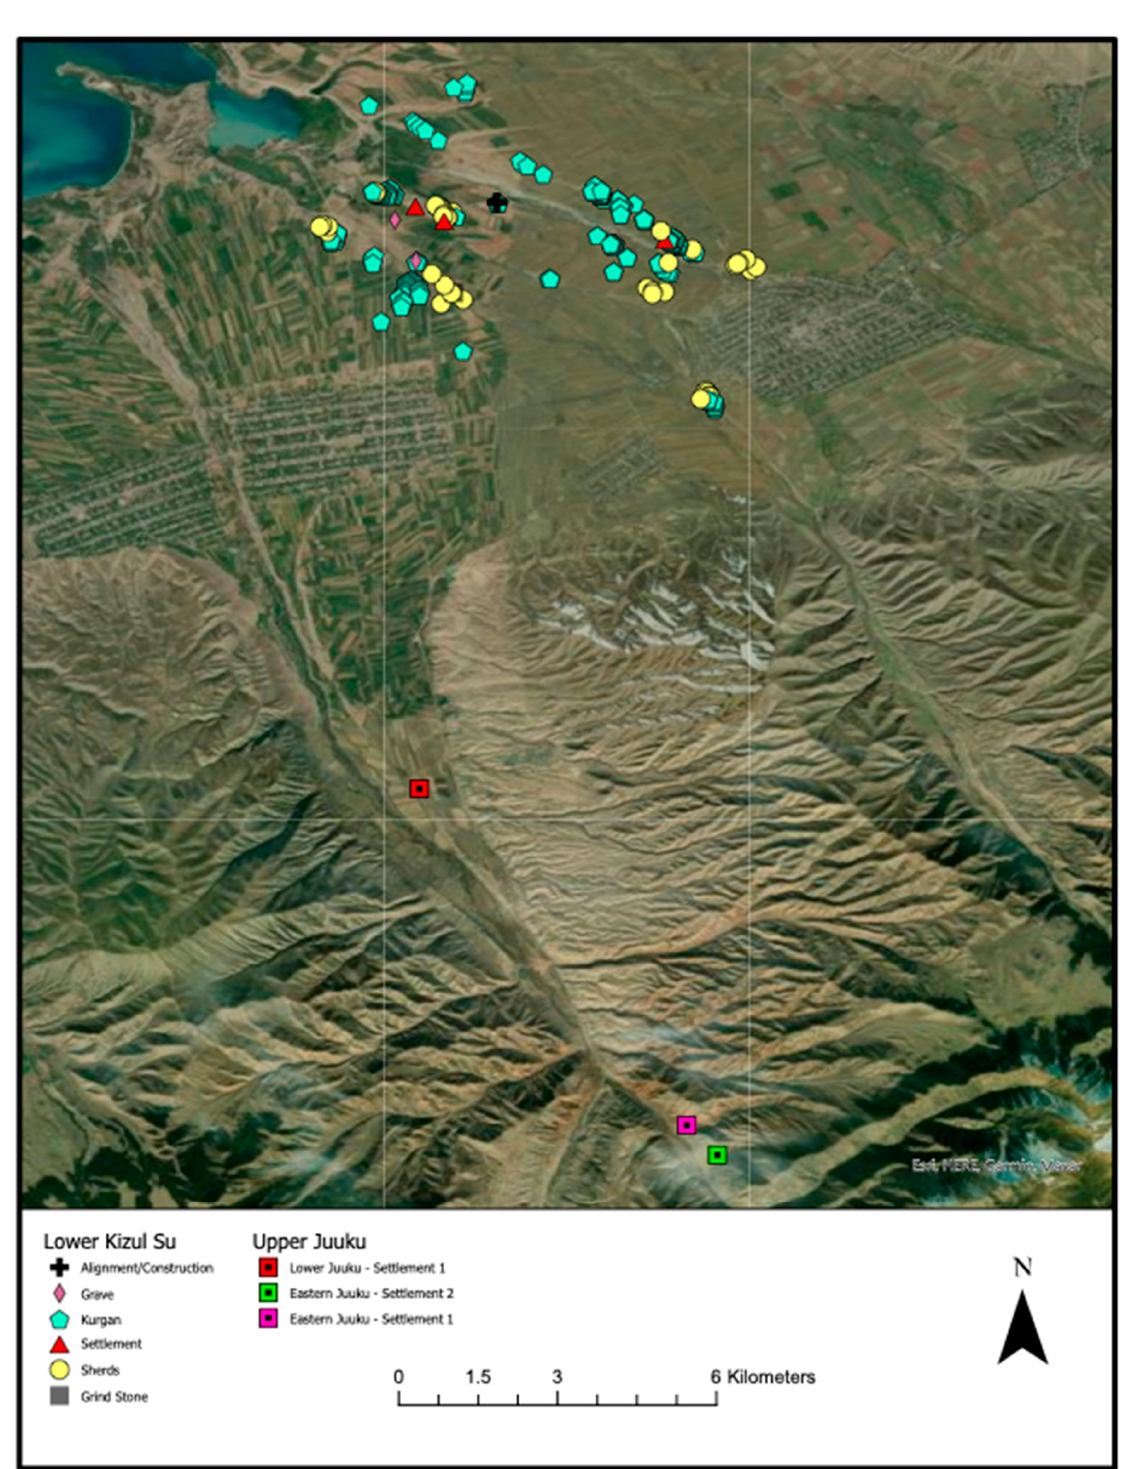
Figure 2. Map of Lower Kizil Suu Survey also shows the location of Eastern Juuku, Settlement 1 (1st to 5th century CE), Eastern Juuku, Settlement 2 (10th to 11th centuries CE), and Lower Juuku, Settlement 1 (17th to 19th centuries